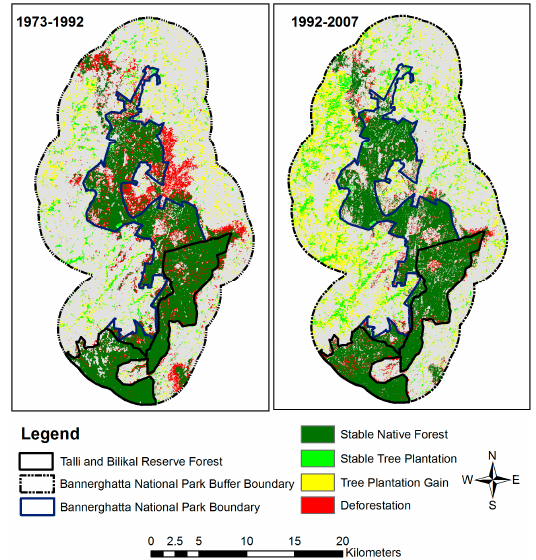
Figure 2. Map showing forest loss and plantation gain between 1973–1992 and 1992–2007.